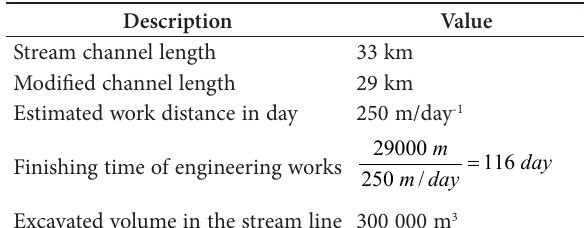
Table 5. Characteristics of engineering